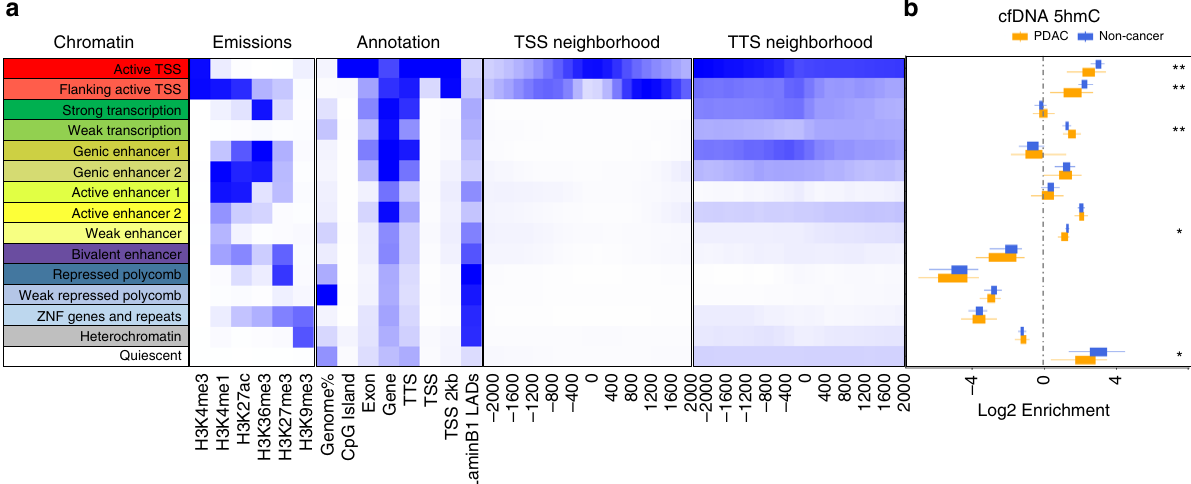
Fig. 2 Differential 5hmC enrichment over chromatin states identi fi ed in PDAC primary tissue in PDAC cfDNA compared with non-cancer cfDNA samples. a Chromatin states observed in two primary PDAC tumor tissues as determined by 6 histone markers; H3K4me1, H3K4me3, H3K9me3, H3K27ac, H3K27me3, and H3K36me3. b Box plots depicting 5hmC occupancy in PDAC ( n = 41) and non-cancer (NC, n = 38) cfDNA cohorts over the chromatin states determined in PDAC primary tissue samples. Center line represents median, bounds of box represent 25th and 75th percentiles and whiskers are Tukey whiskers. Statistical signi fi cance in PDAC vs non-cancer cfDNA enrichment, as determined by two-sided Wilcoxon test, is denoted by ** ( p value < 0.00001) and * ( p value < 0.0001). p -values are 1.85E − 06 (active TSS), 1.28E − 06 ( fl anking active TSS), 8.59E − 06 (weak